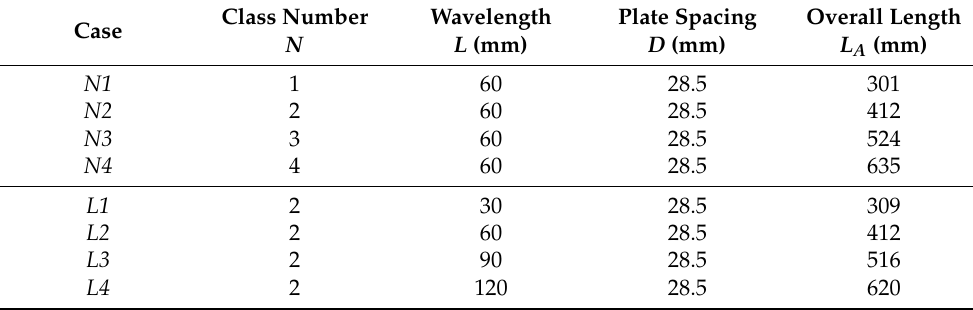
Figure 2. Parameter definition of curved vane demisters. Table 2. The basic geometric parameters of curved vane demisters. Table 1. Selected curved vane demisters for the given parameters and levels. SL. No.